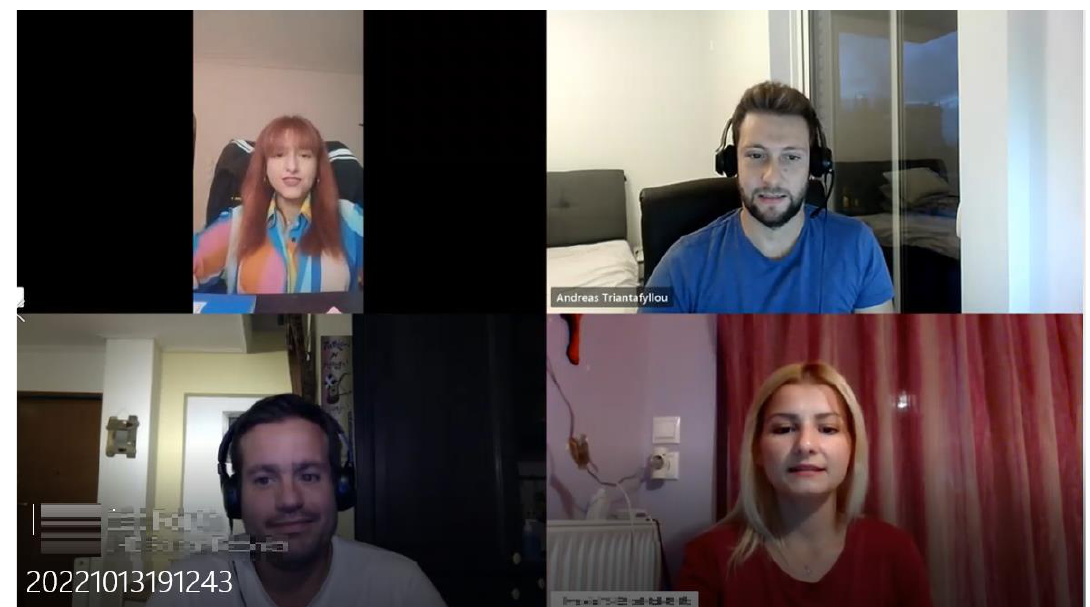
Figure 8. Four people into adjusted e-educational event.